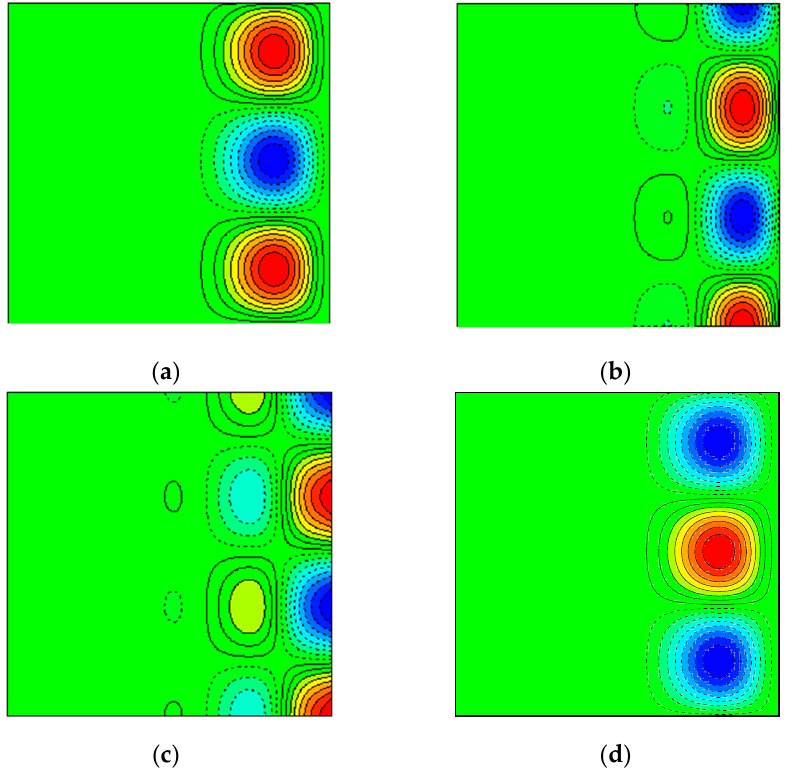
Figure 8. Visualization of the eigenfunctions at the onset of instability for m = 1, k c = 9.262 and Ha = 9. (a) Stream function; (b) azimuthal velocity; ( c ) pressure; ( d ) electric potential.